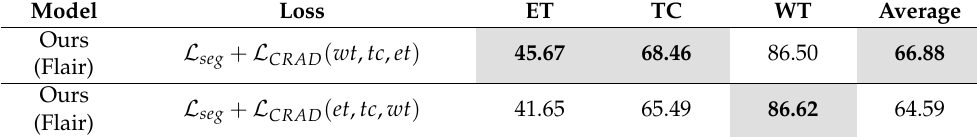
Table 4. Exploration of CRAD loss in the unimodal (Flair) scenario (DSC%).